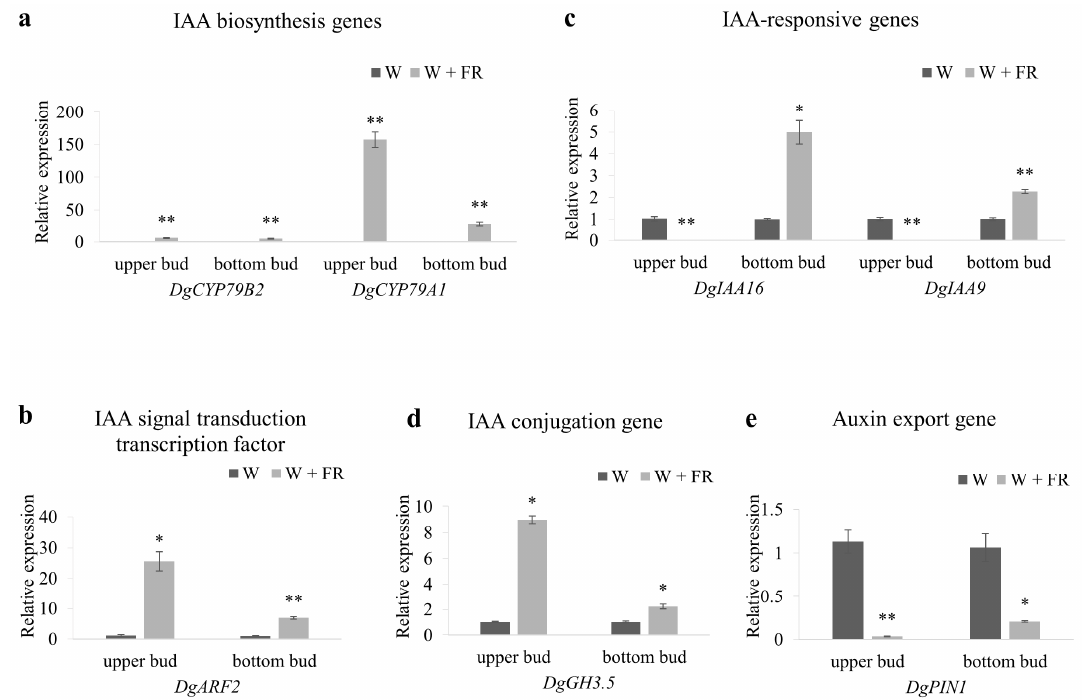
Figure 6. Expression profiles of IAA-related genes and auxin export gene in upper bud and bottom bud of plants grown under high R:FR for 41 days (nearly 45 cm height) and then either maintained under high R:FR or provided with low R:FR for 8 h. ( a ) IAA biosynthesis genes DgCYP79B2 and DgCYP79A1 ; ( b ) IAA signal transduction transcription factor DgARF2 ; ( c ) IAA-responsive genes DgIAA16 and DgIAA9 ; ( d ) IAA conjugation gene DgGH3.5 ; ( e ) Auxin export gene DgPIN1 . Data are mean ± SE of three biological replicates. Asterisks indicate significant differences between the treatment conditions W and W + FR for each position-bud at p < 0.05 (*) and p < 0.01 (**) level.